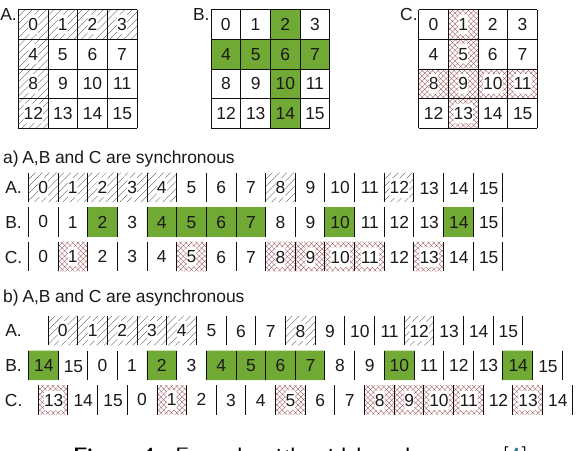
Figure 1. Example with grid-based quorums [4].